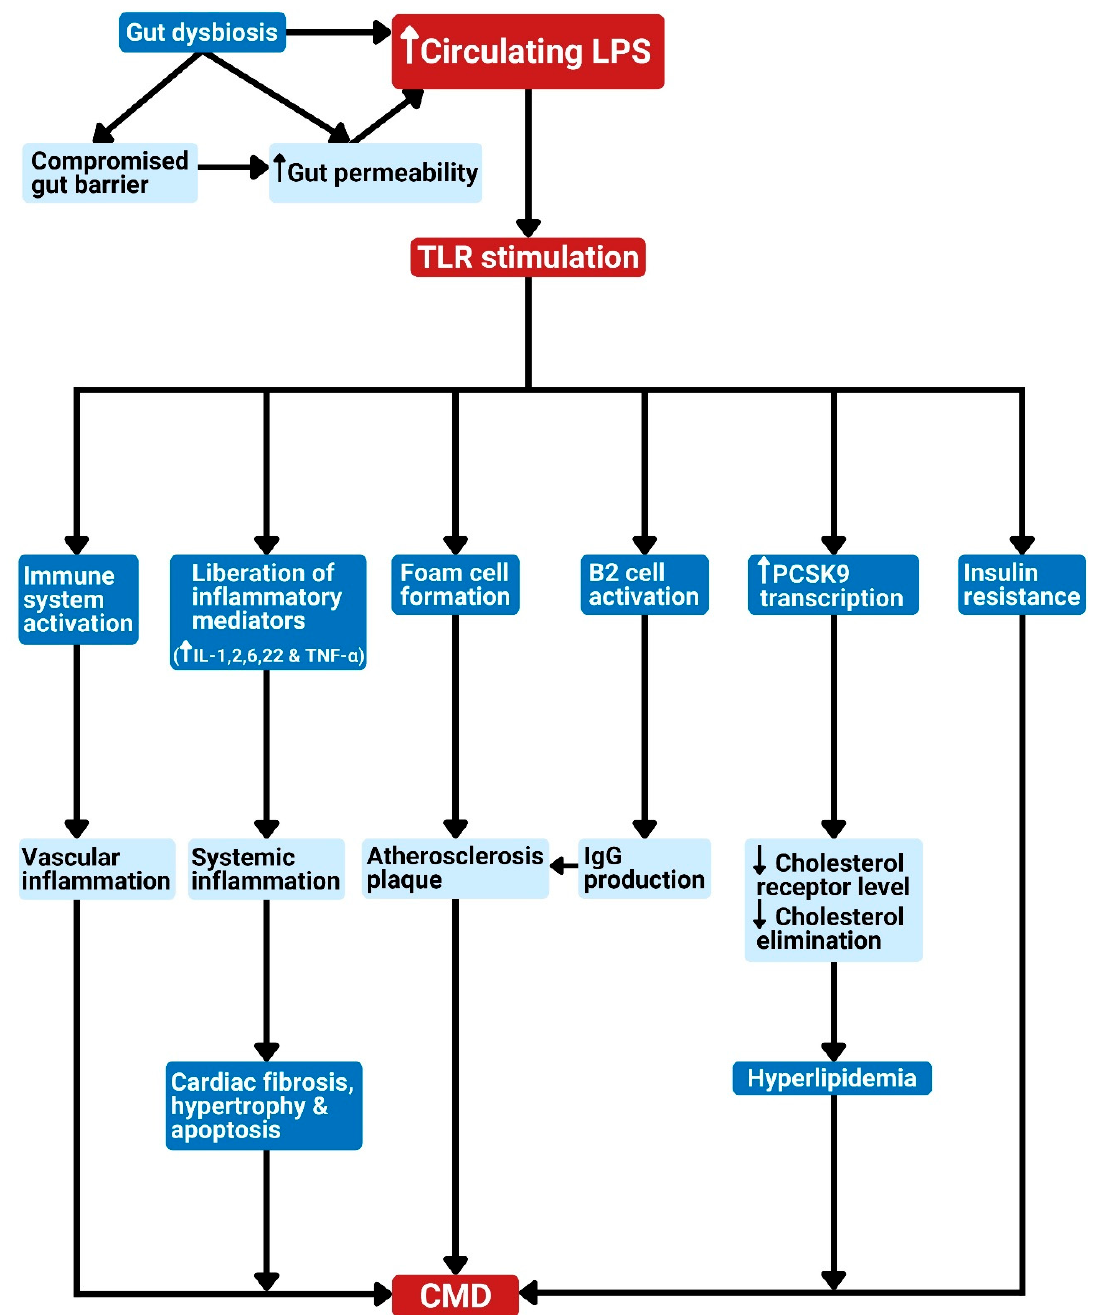
Figure 2. Gut dysbiosis and metabolism-independent bacteria signal release as linked to cardiometabolic diseases. Dysbiosis results in elevated bacterial LPS in circulation. The LPS in the bloodstream can stimulate TLR to produce the following effects: 1. Activation of the host immune system leads to vascular inflammation. 2. Liberation of inflammatory cytokines leads to systemic inflammation, which can cause cardiac apoptosis, fibrosis, or hypertrophy. 3. Promotion of foam cell formation leads to atherosclerosis plaque. 4. Stimulation of B2 cell activation in the spleen results in IgG production and eventually atherosclerosis development. 5. Stimulation of PCSK9 transcription, which reduces cholesterol elimination, leading to hypercholesterolemia. 6. The promotion of insulin resistance. These effects can lead to CMD. CMD: cardiometabolic diseases; LPS: lipopolysaccharide; TLR: Toll-like receptor; PRR: pattern recognition receptor; IL: interleukin; TNF- α : tumor necrosis factor-alpha; PCSK9: proprotein convertase subtilisin/kexin type 9; IgG: immunoglobulin G.